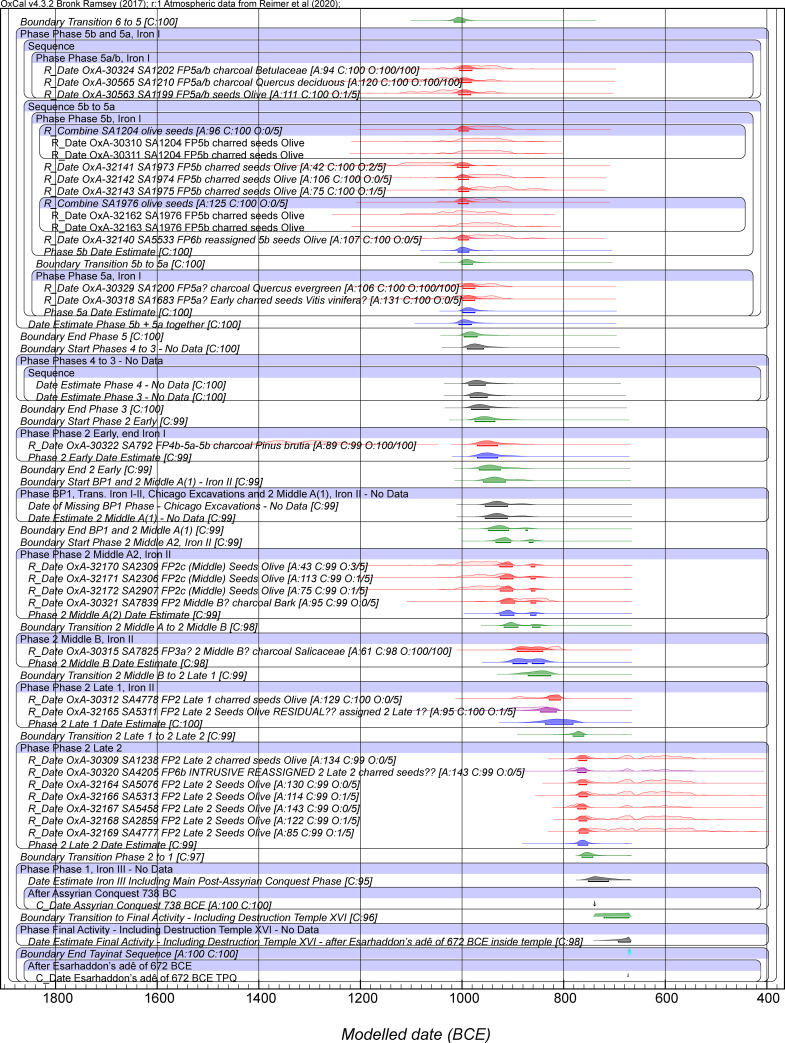
Model 2 (excluding OxA-32139): Bayesian chronological model for Tell Tayinat Iron Age sequence, part 2.Otherwise, see caption to Fig 3.